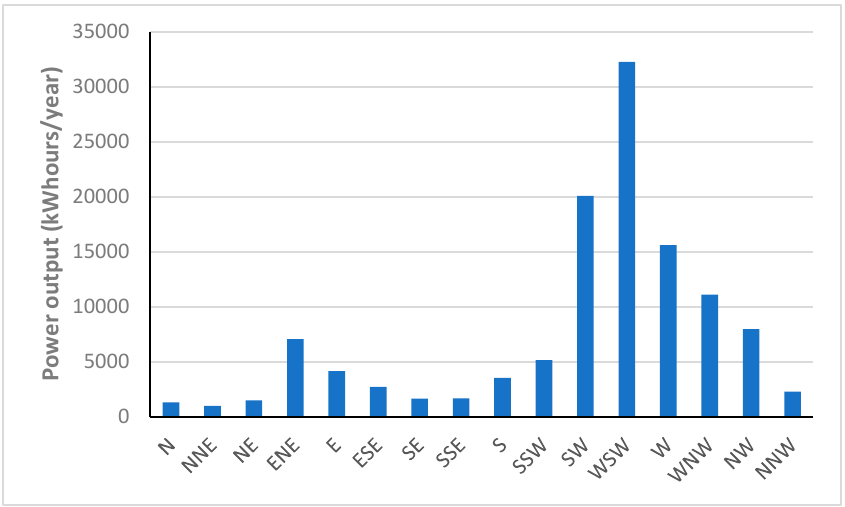
Figure 15. The annual wind power from different directions.